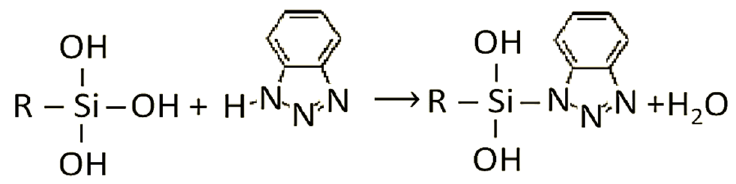
Scheme 1. Polycondensation reaction of silanol and benzotriazole.